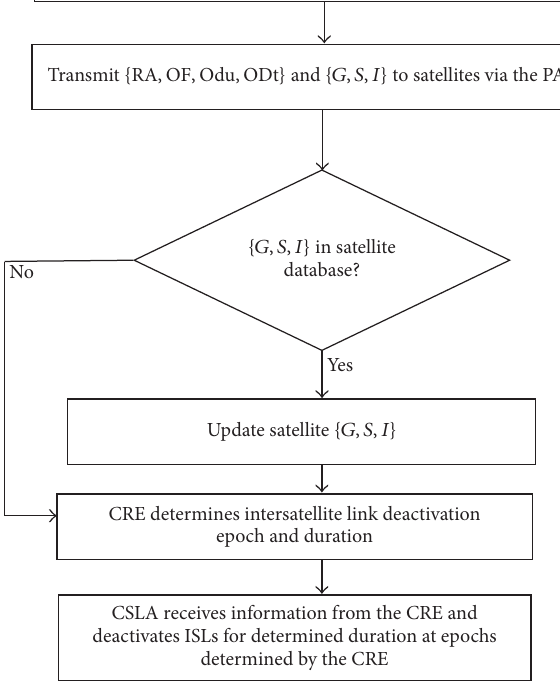
Figure 4: Flowchart of the learning framework.